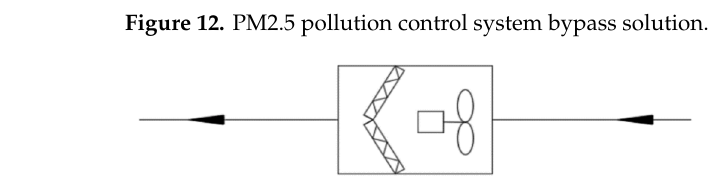
Figure 12. PM2.5 pollution control system bypass solution.